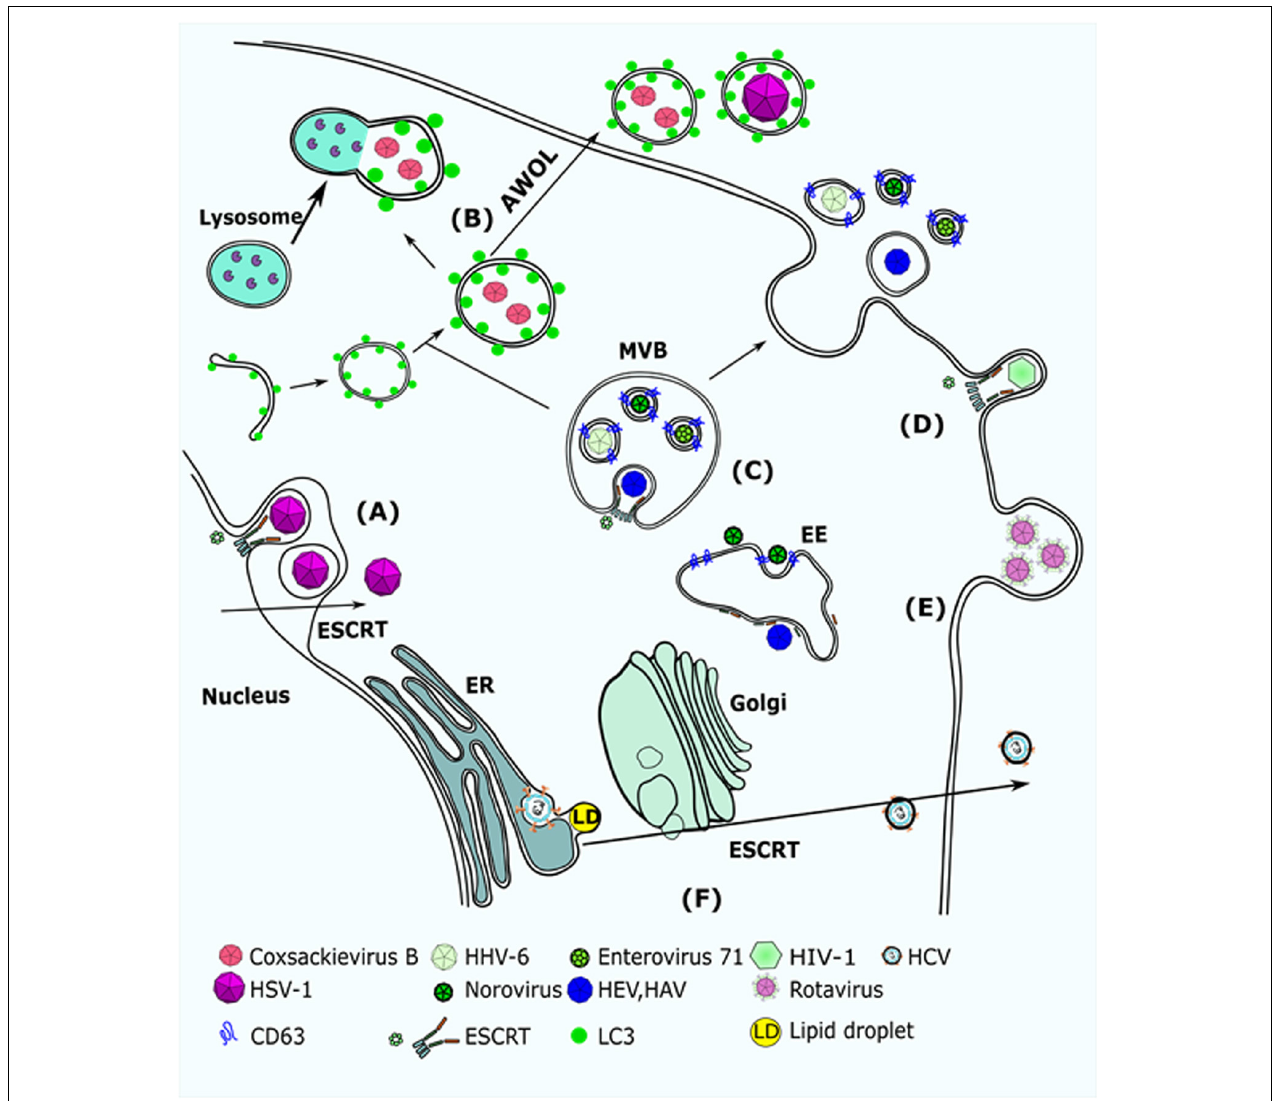
FIGURE 2 | Viruses that utilize EV biogenesis mechanisms to mediate their release. (A) HSV-1 requires Alix and ESCRT-III for nuclear de-envelopment. Depletion of Alix results in accumulation of capsids in the internuclear space. (B) Coxsackievirus B (CVB3) was detected in autophagosome-like vesicles that were carrying LC3. It was suggested that CVB3 uses AWOL to increase its release from infected cells. HSV-1 was also suggested to use AWOL in oligodendroglial cells. (C) HHV-6, Norovirus, and EV71 were detected in CD63 + MVBs. (D) HIV-1 Gag recruits Alix to the plasma membrane, which mediates assembly of ESCRT-III and promotes scission of HIV virions. (E) Rotavirus was detected in large protrusions from the plasma membrane and in microvesicles that were larger than 500 nm. (F) HCV replicates in lipid enriched domains of the ER membrane and egresses through the Golgi to the plasma membranes. Extracellular release of HCV requires Hrs, a factor of the ESCRT-0 complex. AWOL, autophagosome-mediated exit without lysis; MVB, multi-vesicular body; EE, early endosome; ESCRT, endosomal complex required for